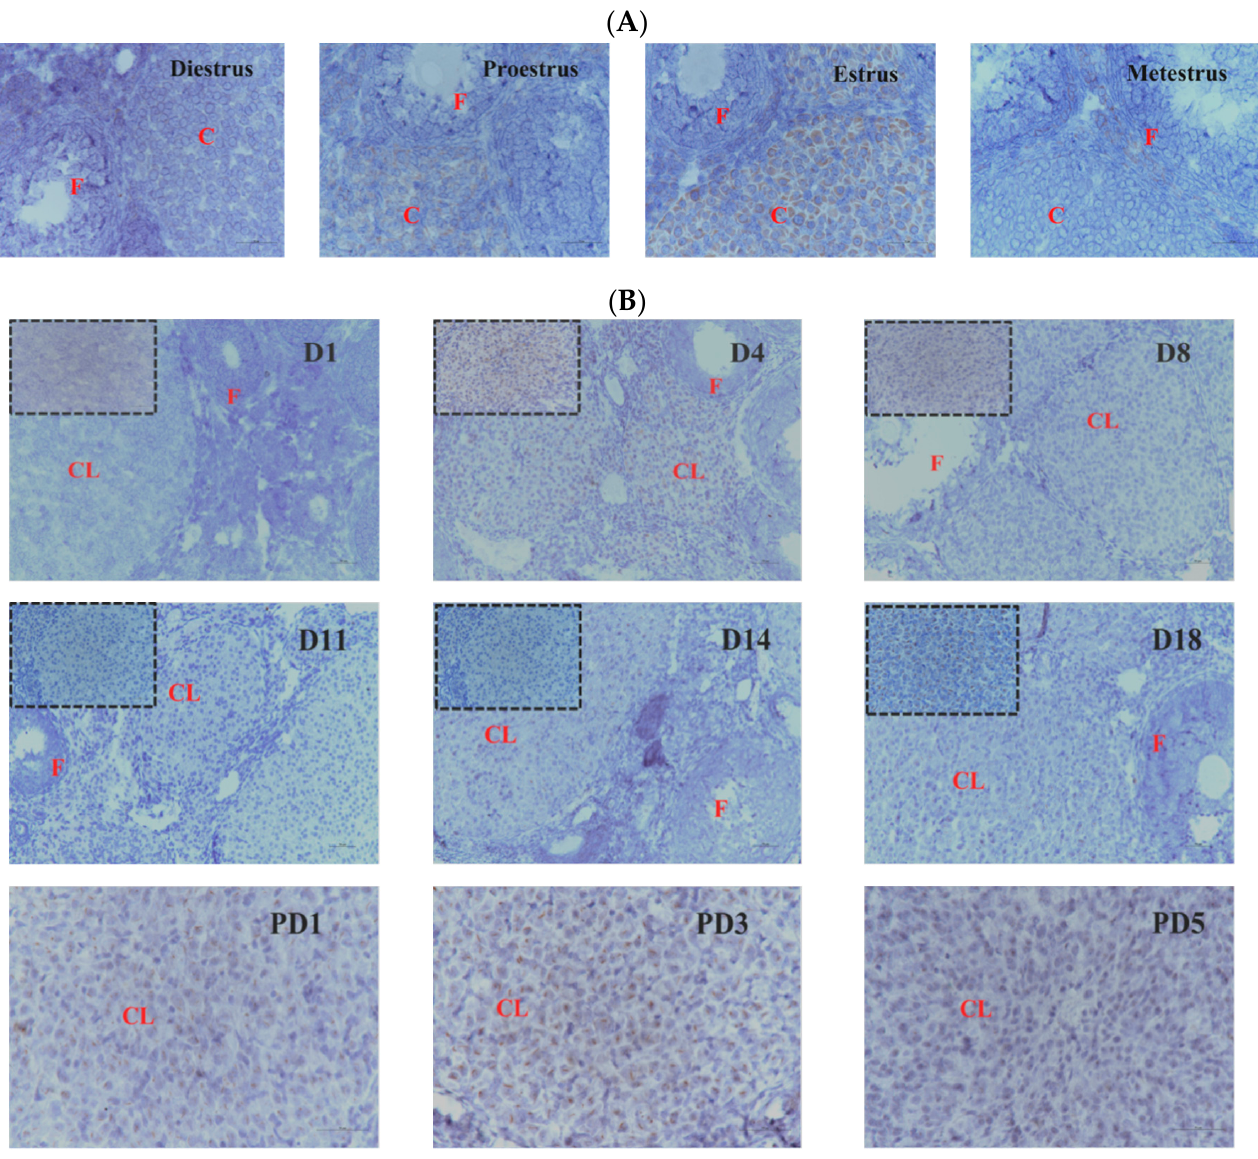
Figure 1. RNAscope of Hand2os1 expression in the ovary on days 1–18 of pregnancy (D1–D18) and days 1–5 of postpartum (PD1–PD5). Positive expression results in a brown color. ( A ) Hand2os1 expression and localization in ovaries during the estrus cycle. ( B ) Hand2os1 expression in ovaries during pregnancy. CL, corpus luteum; F, follicle. Scale bar = 50 μ m.